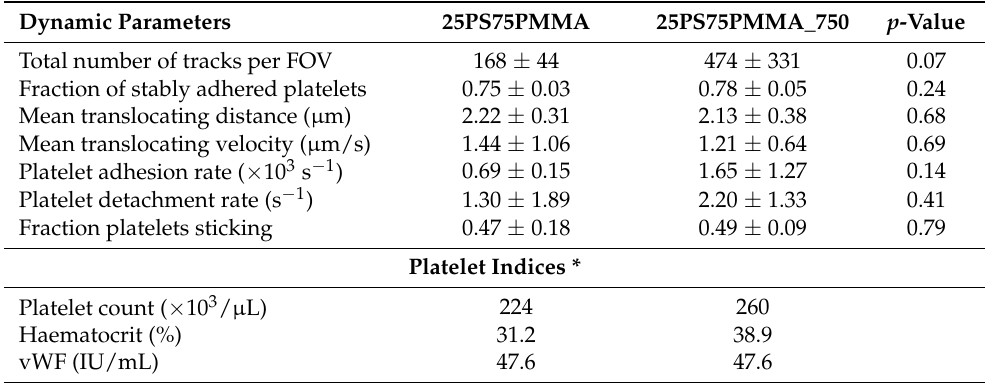
Table 5. Dynamic platelet parameters derived from the autologous platelet function algorithm analysis (n = 5 ± SD) and the associated relevant platelet indices from haematological analysis of the healthy donor